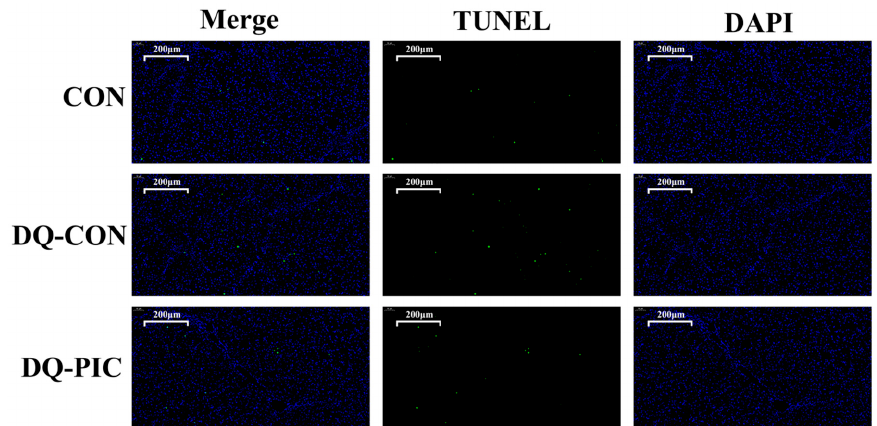
Figure 2. Effects of piceatannol supplementation on apoptosis of hepatic cells in diquat-induced piglets. TUNEL , terminal deoxyribonucleotidyl transferase-mediated deoxyuridine triphosphate nick end labeling; CON , piglets were orally administrated vehicle solution (0.5% sodium carboxymethyl cellulose) and challenged with sterile saline; DQ-CON, piglets were orally administrated vehicle solution and challenged with diquat (10 mg/kg body weight); DQ-PIC, piglets were orally administrated piceatannol (80 mg/kg/day) and challenged with diquat (10 mg/kg body weight).